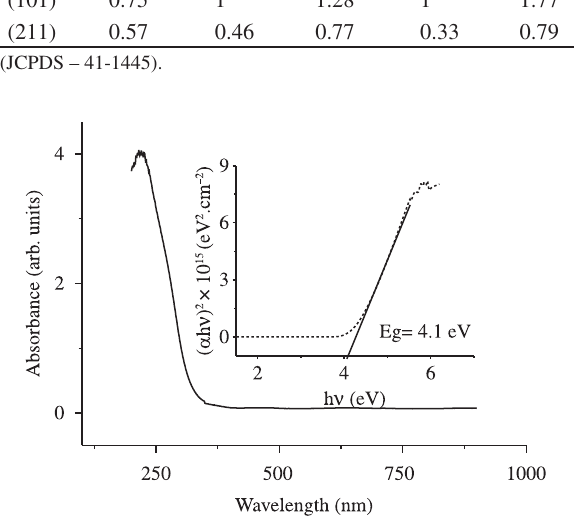
Figure 3. Optical absorption spectra for undoped SnO experimentally obtained direct bandgap, through extrapolation of linear range of ( s h υ ) 2 for y = 0.